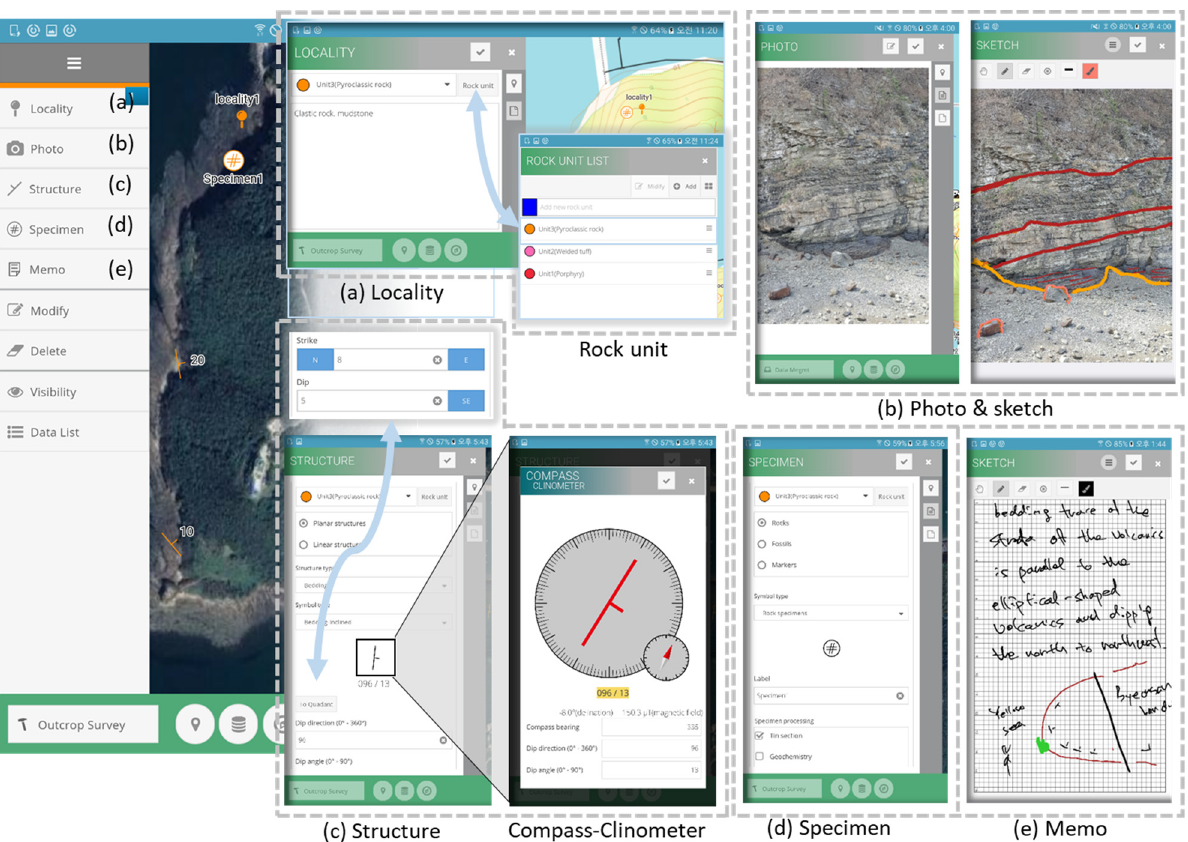
Figure 4. Outcrop survey tool and functions: ( a ) locality input panel and associated rock units, ( b ) photograph acquisition and sketching, ( c ) structure input panel and associated measurement tool (dip/dip ↔ quadrant switching of structural notation), ( d ) specimen input panel, and ( e ) handwritten memo and sketch panel.